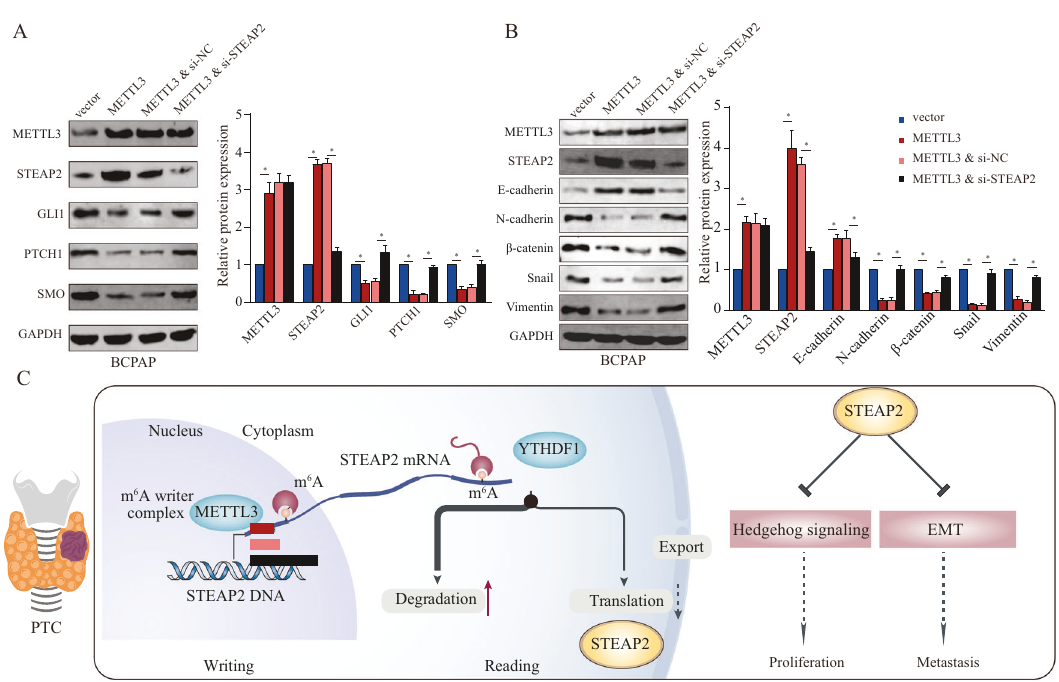
Fig. 8 METTL3/STEAP2 m6A axis regulates hedgehog signaling pathway and EMT in PTC. BCPAP PTC cell lines were transfected with METTL3-overexpression (METTL3) plasmids and siRNA targeting STEAP2 (si-STEAP2) as indicated. A , B Effect of METTL3/STEAP2 axis on the expression of Hedgehog signaling pathway-related proteins (Smo, Gli1, and PTCH1) and EMT markers (E-cadherin, N-cadherin, snail, vimentin, and β -catenin) in PTC cells were quanti fi ed by western blot assay. C The graphic illustration of METTL3-mediated m6A modi fi cation modulating malignant phenotype of PTC through enhancing STEAP2 expression and then restraining Hedgehog signaling pathway and EMT. All data are presented as the mean ± standard deviation of three independent experiments. * P < 0.05, ** P < 0.01, and *** P <